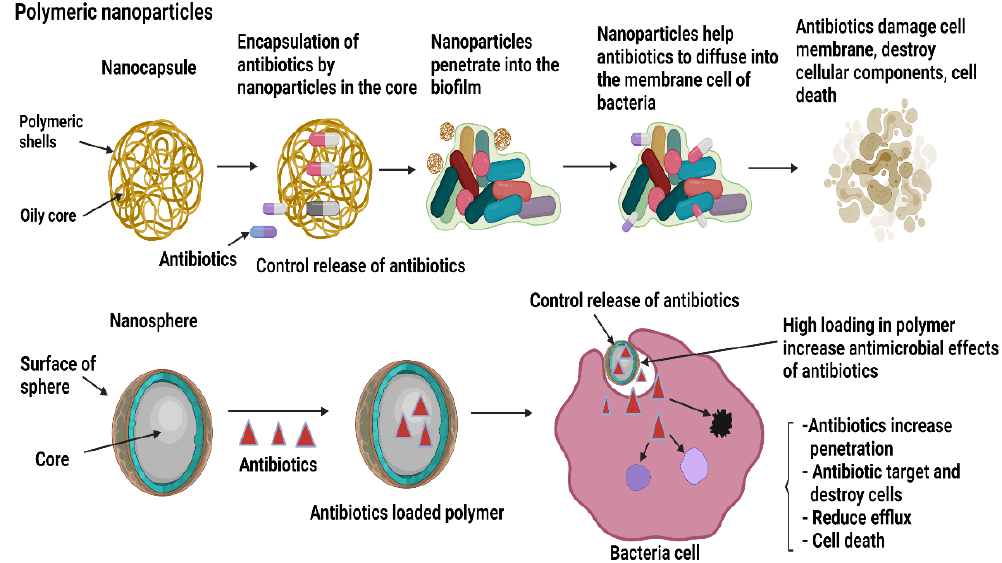
Figure 6. The mechanism of actions of polymeric nanoparticles as drug carriers via controlled release of drugs to target and destroy biofilms.